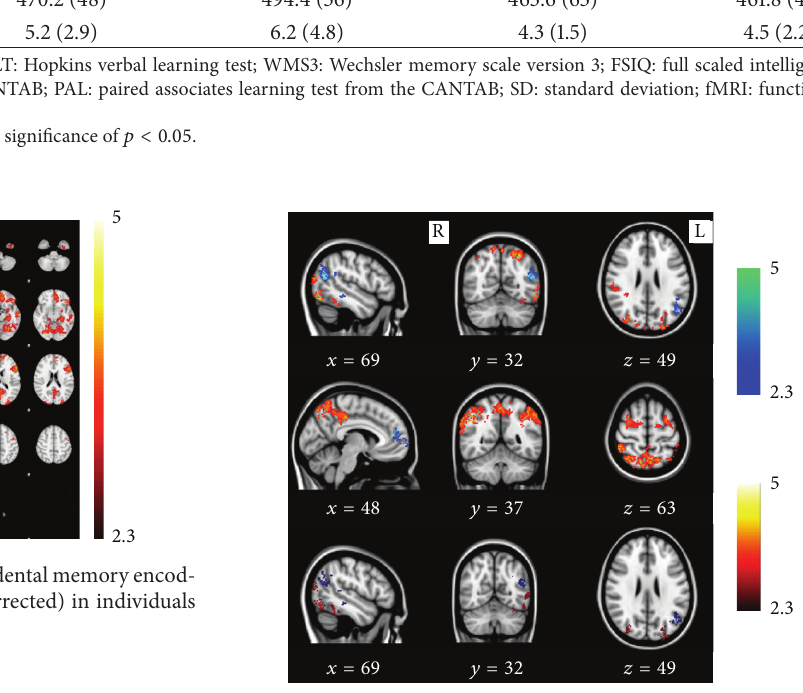
Figure 2: BOLD-fMRI activation differences within twin pairs discordant for type 2 diabetes. Results are displayed in all pairs (22 pairs, first row), monozygotic pairs (8 pairs, second row), and dizygotic pairs (14 pairs, last row). Blue : areas of decreased activation in type 2 diabetes mellitus. Red: areas of increased activation in type 2 diabetes mellitus. 𝑥 , 𝑦 , and 𝑧 refer to Montreal Neurological Institute (MNI) voxel coordinates for the selected